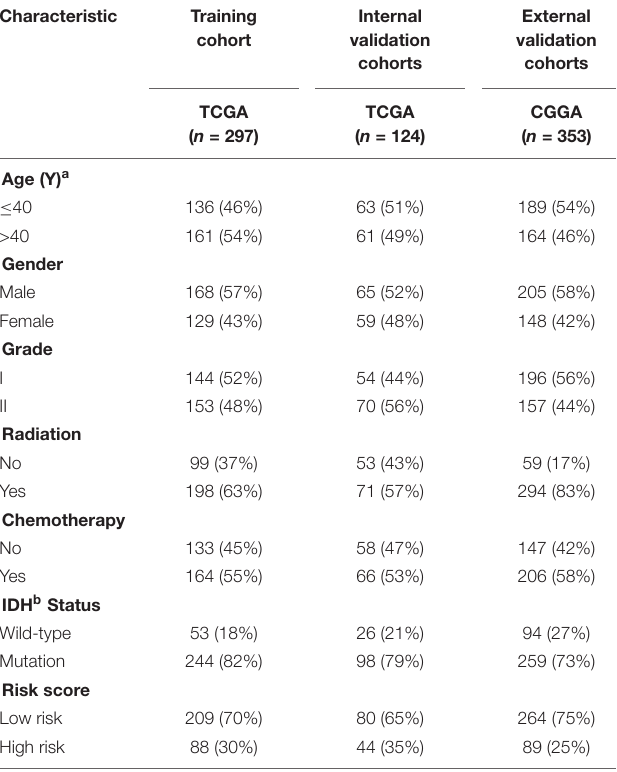
TABLE 1 | Clinicopathological characteristics of primary LGG patients from the TCGA and CGGA databases.